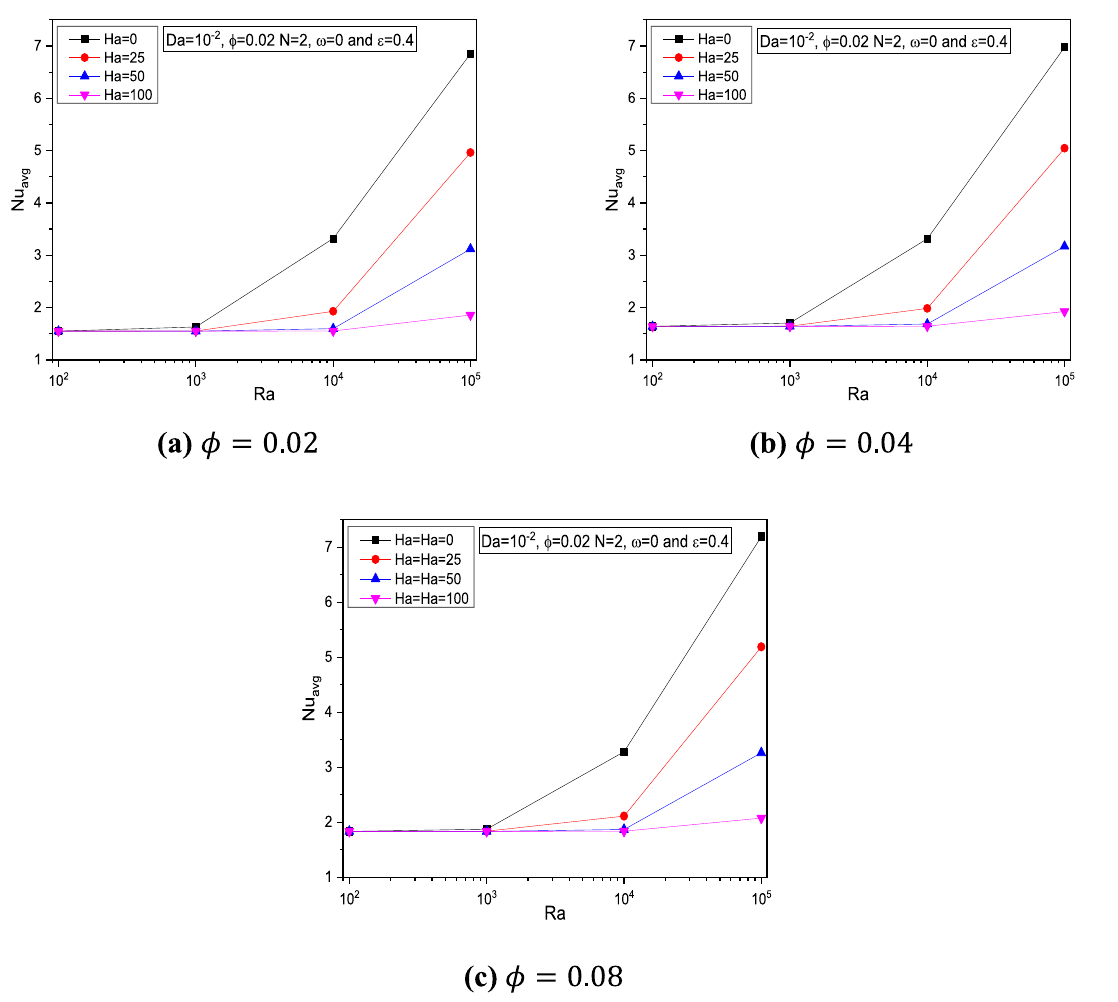
2 0.4 , ω 0, Da 10 at ( a ) φ − = = =